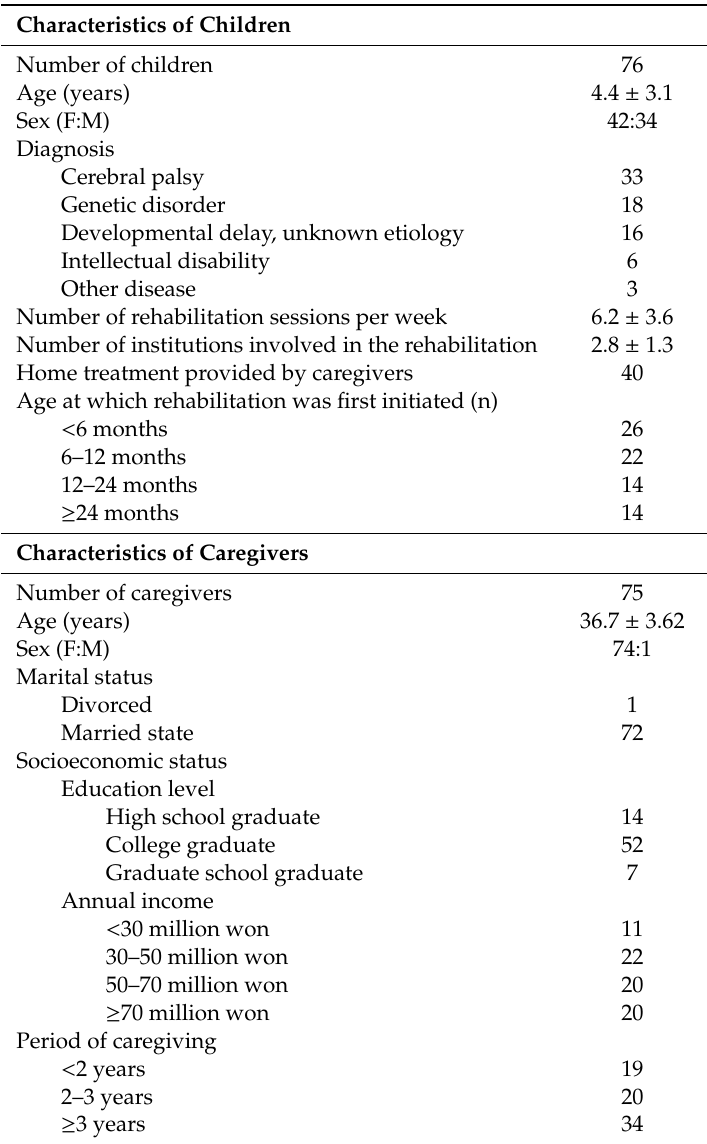
Table 1. Characteristics of the study